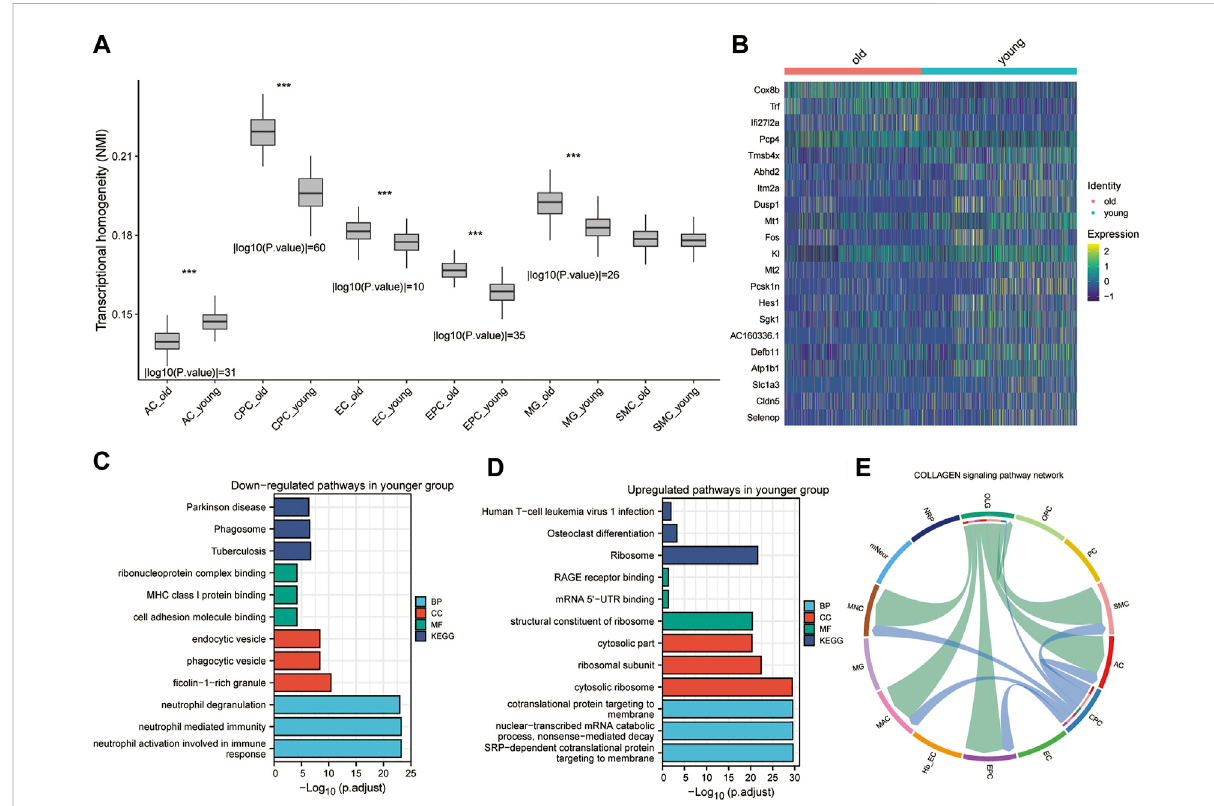
FIGURE 3 Heterogeneity and differential analysis of single cells in mouse brain tissue. (A) . Box plot showing transcriptional heterogeneity between older and younger cells for eachcell subtype using NormalizedMutual Information (NMI).* p < 0.05, ** p < 0.01, *** p < 0.001. (B) The heatmap shows the main DEGs in CPC obtained by applying the “ FindVariableFeatures ” function. (C,D) Downregulated and upregulated GO (C) and KEGG pathways (D) in the younger group. (E) . CellChat-based results show the association of OPC cell populations with other cell populations in the collagen signaling pathway